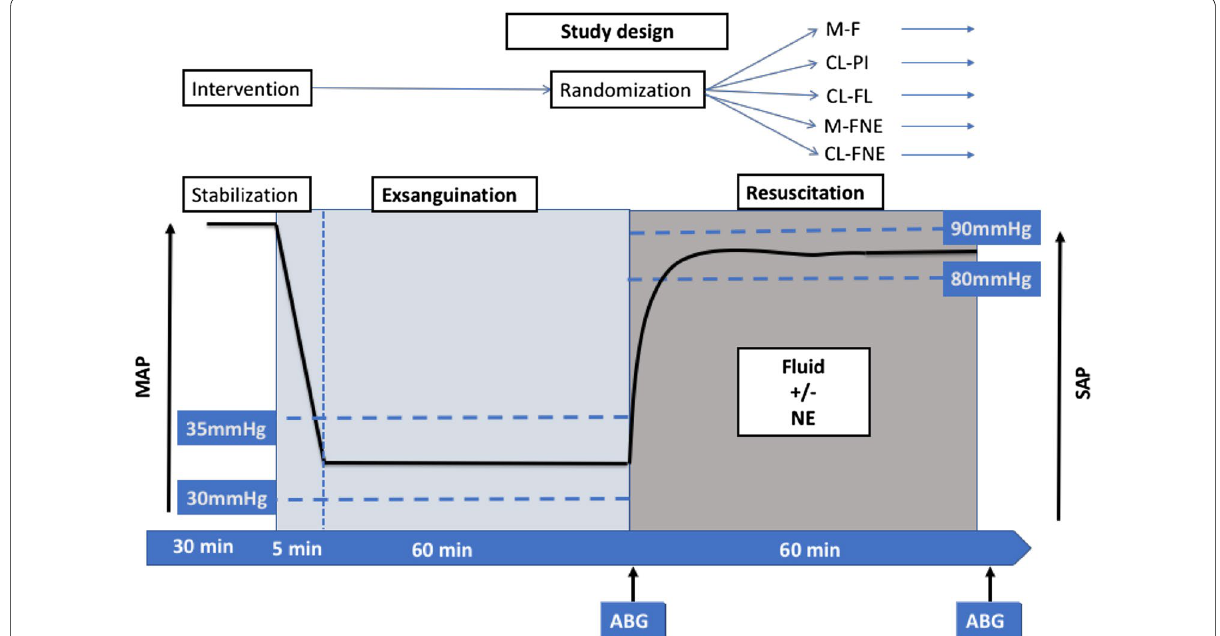
Fig. 1 Experimental protocol. The continuous line represents the evolution of MAP during the two phases of the study (acute exsanguination followed exsanguination or transfusion to maintain MAP between 30 and 35 mmHg). Time is represented on the horizontal arrow. Each phase lasted 60 min. ABG arterial blood gas, M-F manual fluid group, CL-PI closed-loop PI group, CL-FL closed-loop FL group, M-FNE manual fluid and norepinephrine group, CL-FNE closed-loop fluid and norepinephrine